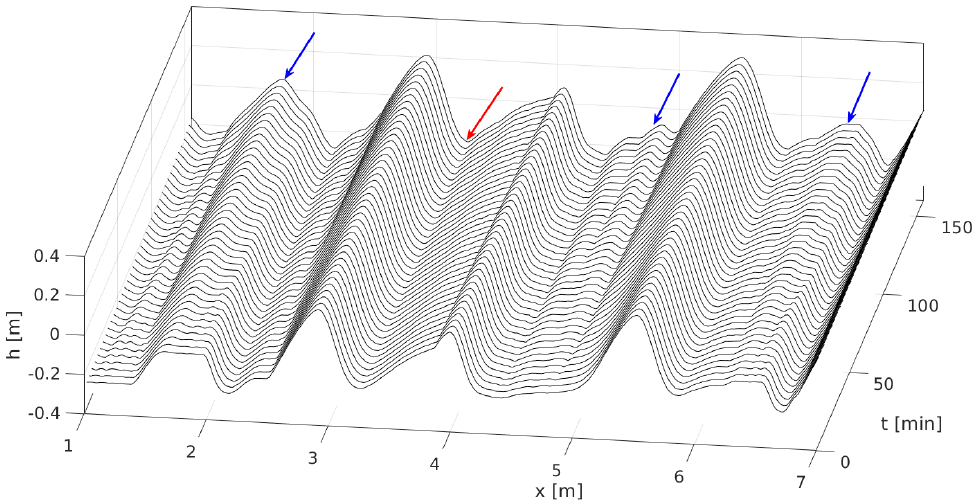
Figure 10. Development of superimposed ripples between the large ripples during 160 min of numerical simulation. The blue arrows indicate the locations where small ripples developed, whereas the red arrow indicates a location where the space between the two adjacent large ripples was insufficient for the development of small ripples.